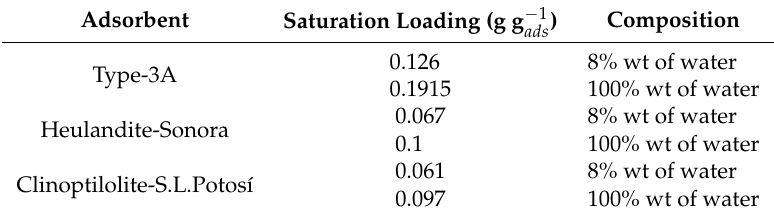
Table 4. Maximum saturations in two different concentrations with a constant temperature of 50 ◦